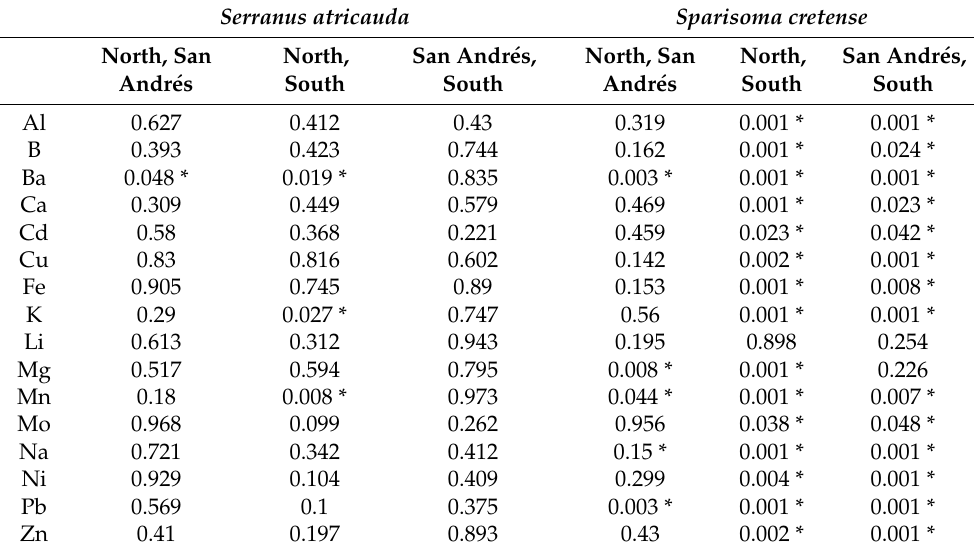
Table 7. Results of pairwise tests examining the significant factor of ‘Zones’ obtained in the two-way PERMANOVA analyzing the variation in the content of heavy metals and trace elements in liver tissue in species according to study zone, considering the level of the factor “Species”.